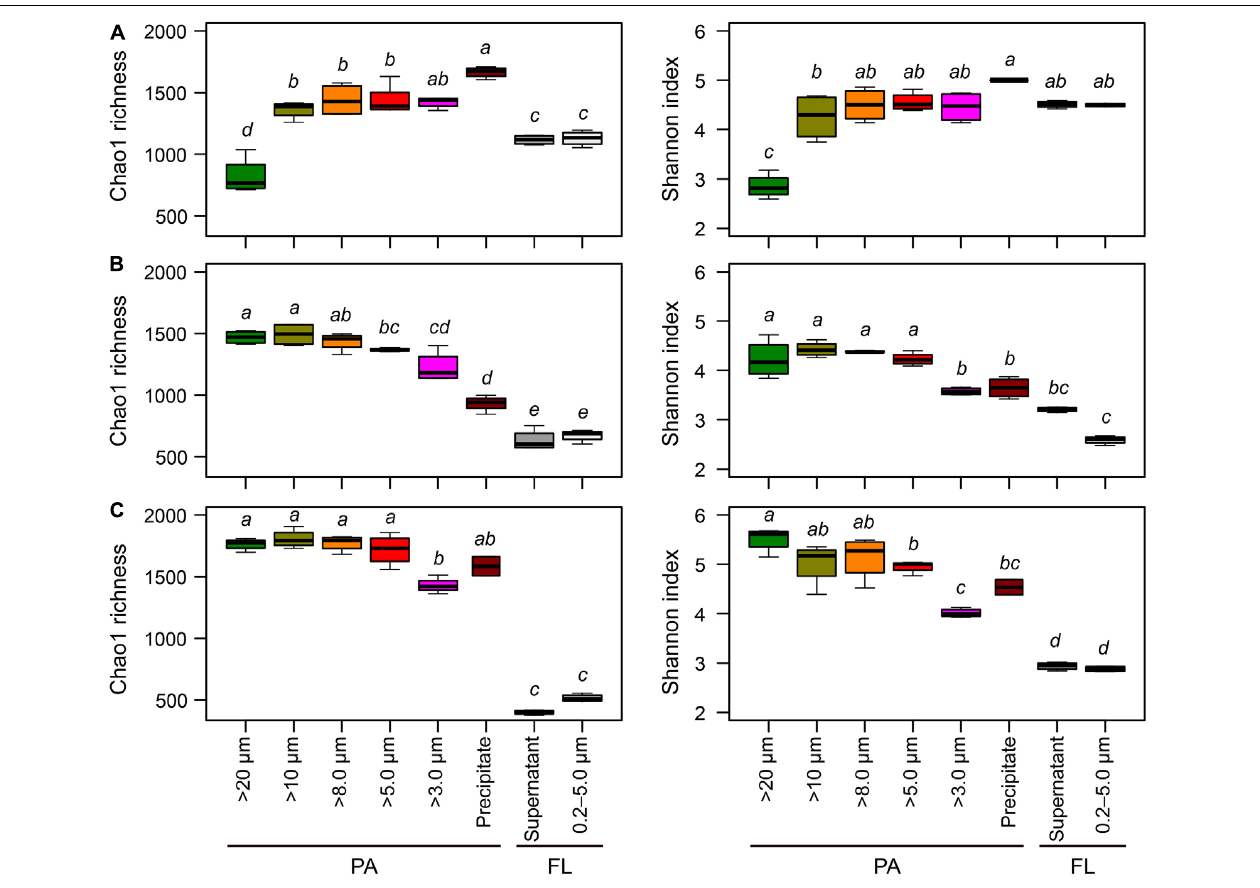
FIGURE 3 | Boxplots of the Chao1 richness and Shannon diversity indices for each sample collection treatment in (A) Lake Taihu, (B) Lake Tianmu, and (C) Lake Fuxian. Diversity indices were calculated using subset of 19,687 sequences per sample. The median values are shown with horizontal black wide lines. Upper and lower edges of the boxes represent the first and third quartile of the distribution of values, with whiskers indicating the lowest and highest values within 1.5 times the interquartile range of the lower and quartiles, respectively. Kruskal–Wallis test was performed to examine the differences among treatments with Holm correction of P -values for multiple comparisons. Different lower-case letters above each boxplot indicate significant differences ( P < 0.05) among treatments. PA, particle-attached; FL,